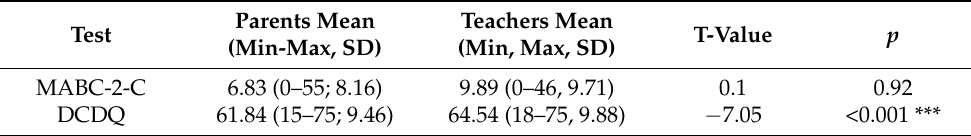
Table 4. Paired samples t -test of the MABC-2-C and the DCDQ between parents and teachers of children without suspected DCD ( n =